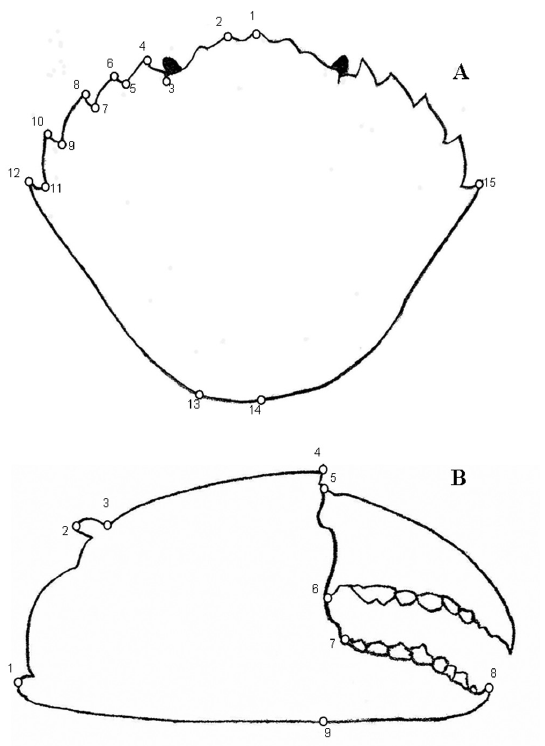
Fig . 2. – Fifteen carapace anatomical landmarks (A) and nine claw anatomical landmarks (B) used in the morphometric